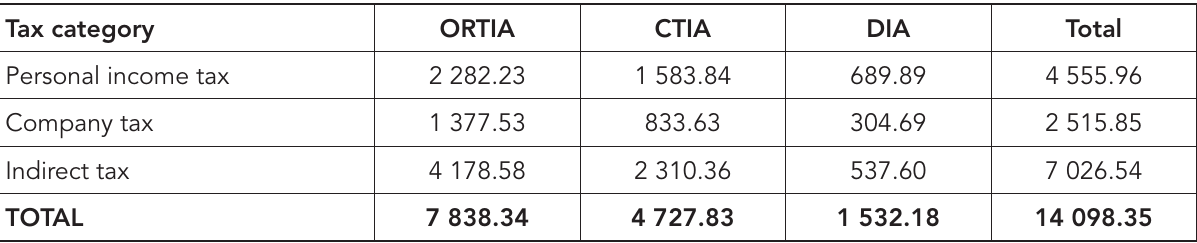
Table V: Total combined tax impacts of ORTIA, CTIA and DIA